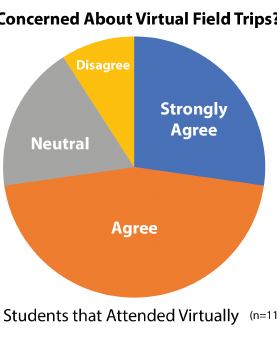
Figure 6. Chart of responses from students that attended SST vir- tually on whether they were concerned about participating in field trips